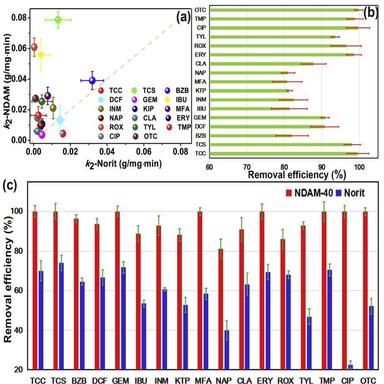
(a) Comparison of pseudo-second-order rate constants (k2) for the adsorption of PPCPs by NDAM-40 and Norit (0= 10 mg/L; m(NDAM-40) = 10 mg/L); (b) removal efficiency of NDAM-40 for 17 kinds of PPCPs within 360 min (0= 1 mg/L; m(NDAM-40)= 10 mg/L); (c) removal efficiency of NDAM-40 (red) and Norit (blue) for 17 kinds of PPCPs within 360 min (0= 0.05 mg/L; m(NDAM)= m (Norit)= 10 mg/L). The experiment was conducted at pH 7. (For interpretation of the references to colour in this figure legend, the reader is re